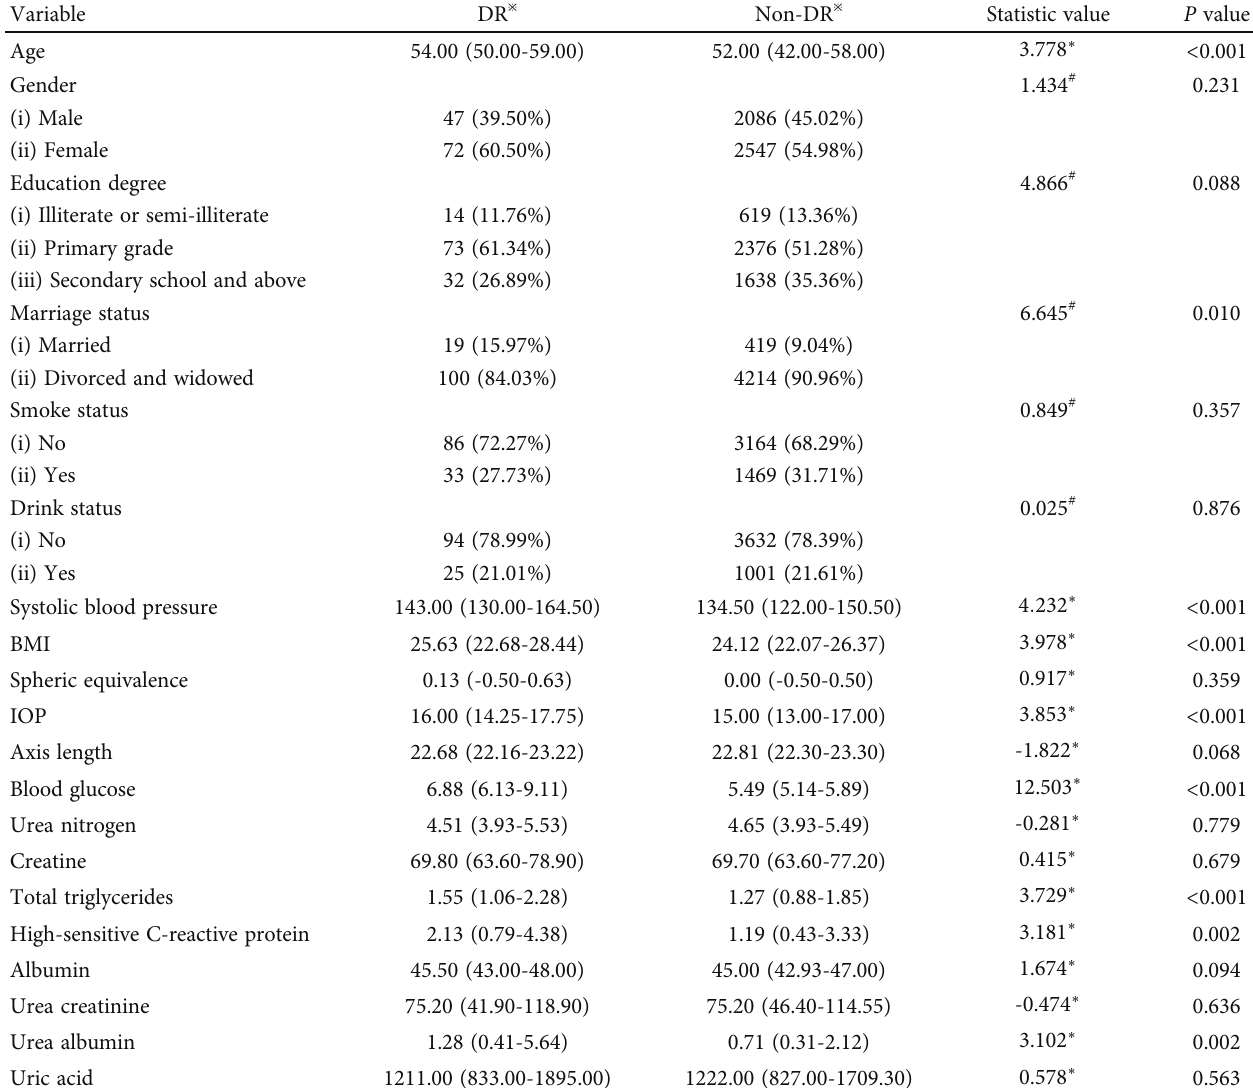
Table 1: Demographic characteristics and univariate analysis ( n = 4572 ).